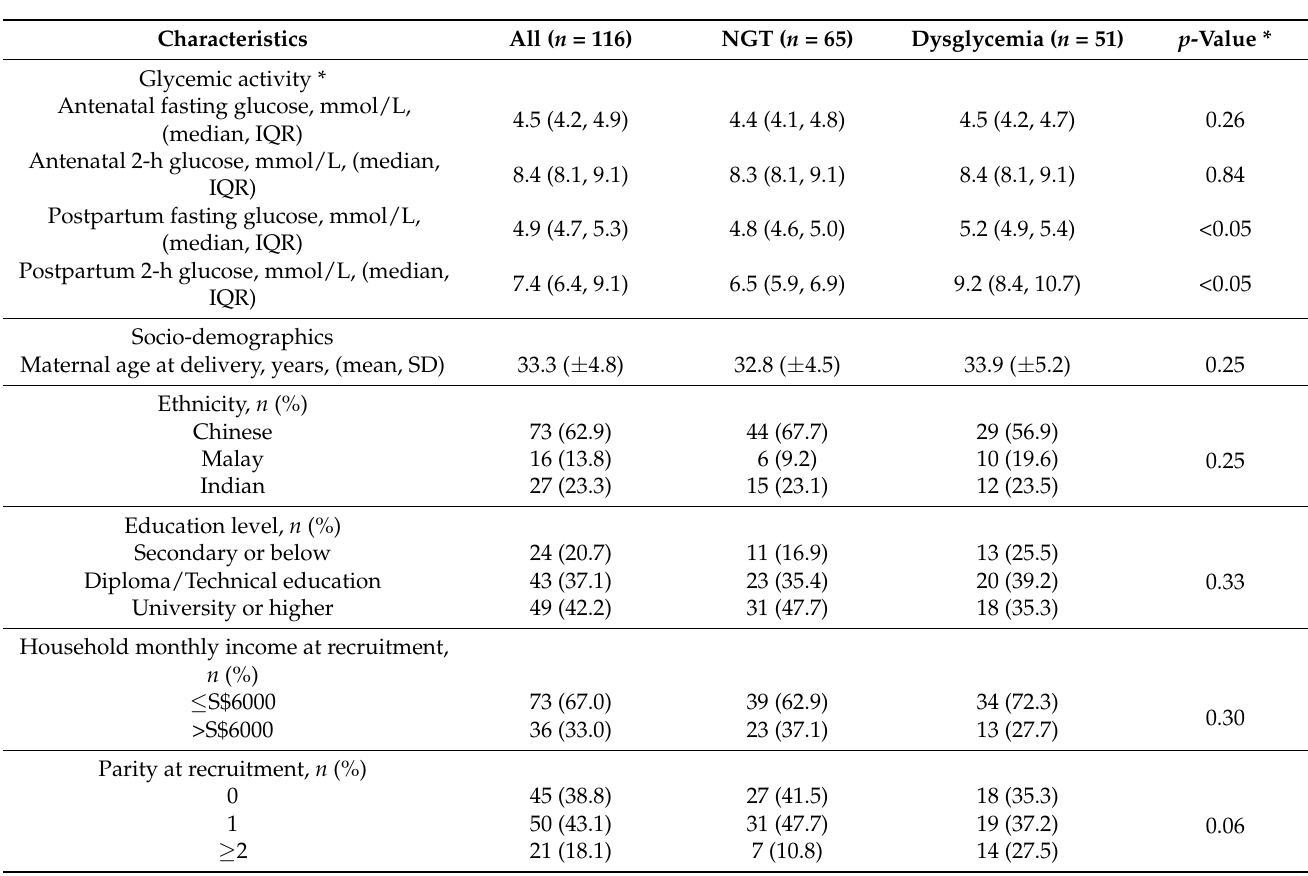
Table 1. Characteristics of women who developed and did not develop dysglycemia 4 to 7 years postpartum after gestational diabetes ( n =